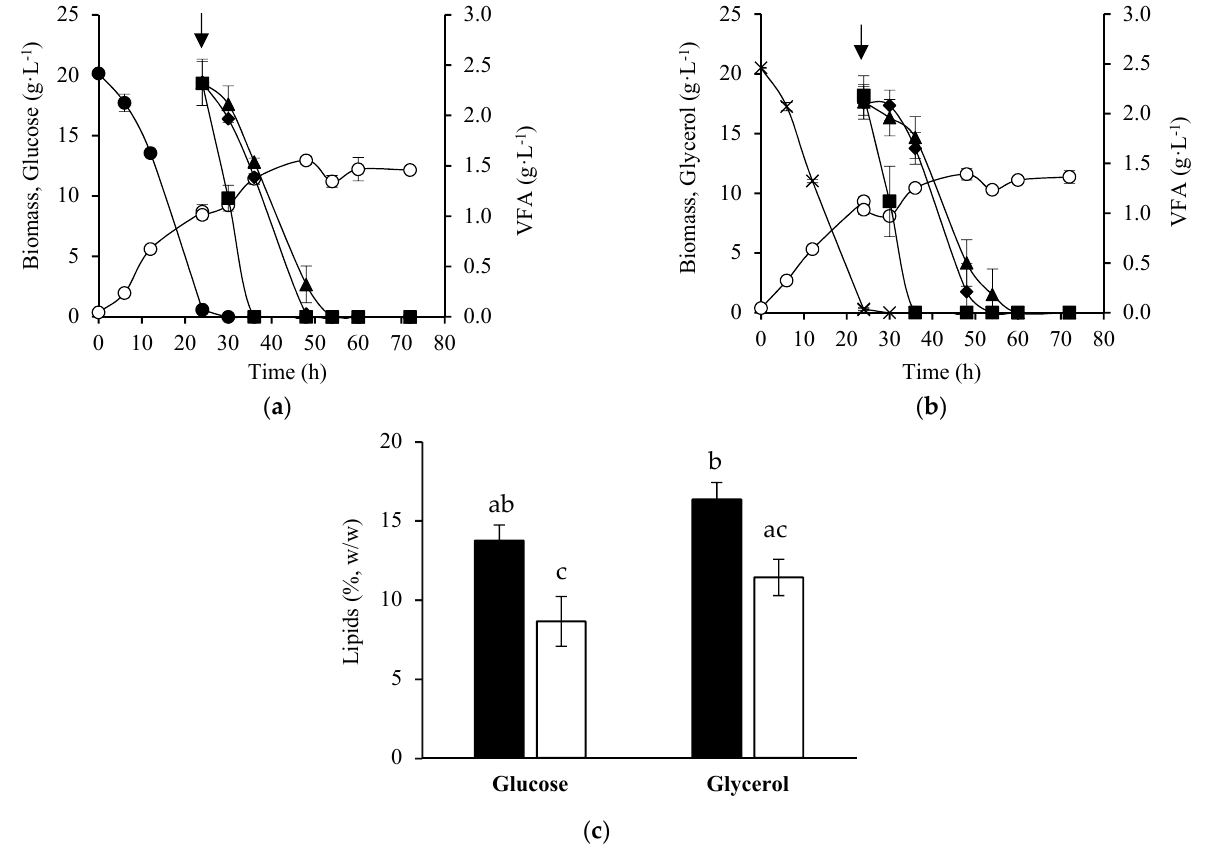
Figure 1. Time course of cellular growth ( ○ ), VFAs ( ■ , acetate; ▲ , propionate; ♦ , butyrate), glucose ( ● ), and glycerol ( x ) concentration obtained in two-stage batch cultures of Y. lipolytica W29. After 24 h of growth in glucose ( a ) or glycerol ( b ), a mixture of 6 g·L − 1 VFAs (2 g·L − 1 acetate, 2 g·L − 1 propionate, and 2 g·L − 1 butyrate) was added to the culture medium. Lipids content of Y. lipolytica cells at 48 h (black bars) and 72 h (white bars) of cultivation ( c ). The error bars represent the standard deviation of two independent replicates.